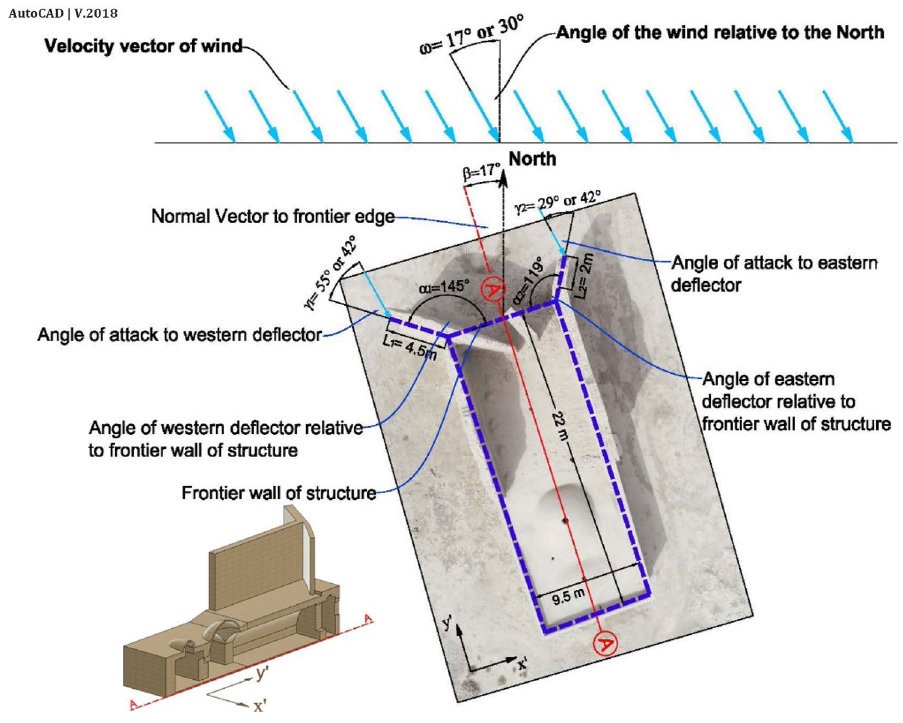
Figure 4. Dimension of elements in the